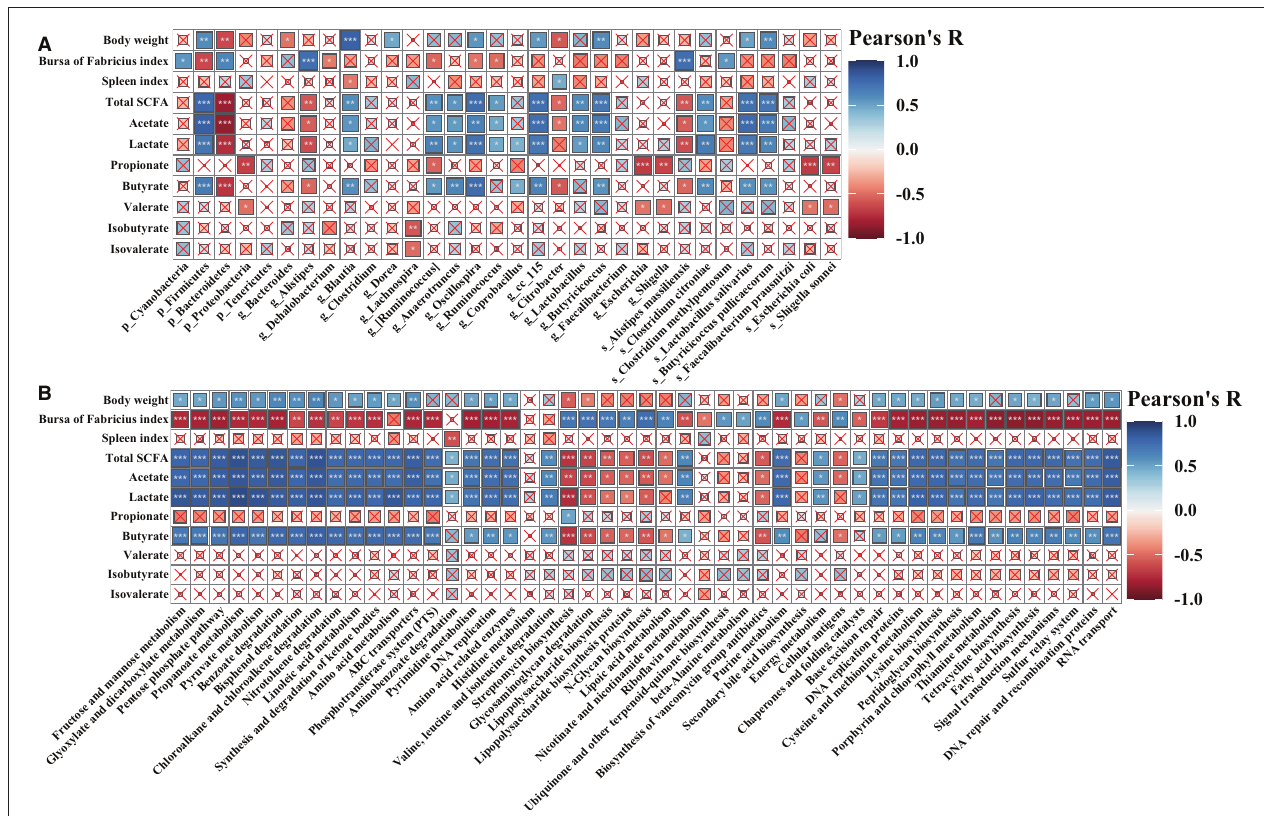
FIGURE 10 | Pearson’s correlation analysis. Correlation of phenotypic variables and microbial communities (A) and microbial-predicted metabolic pathway functions (B) . The color and the dot size represent the correlation coefficient. * p < 0.05; ** p < 0.01; *** p <